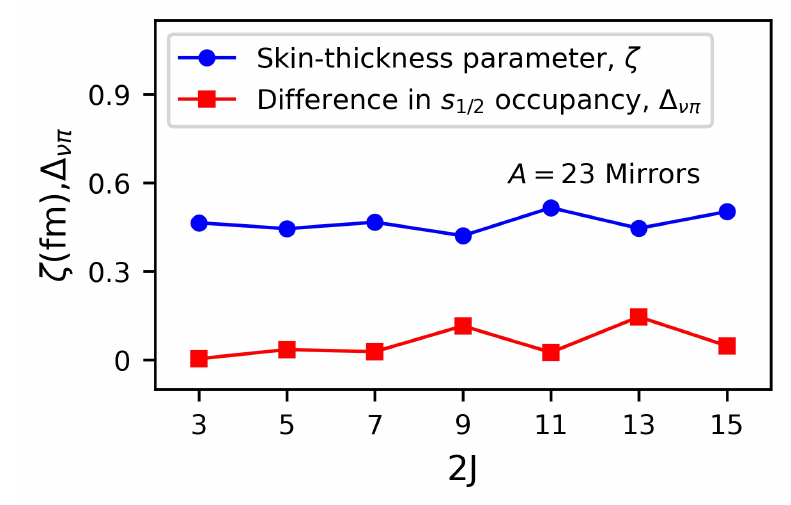
Figure 7. Data from Ref. [11]. Blue circles: the neutron skin thickness parameter, ζ , defined in Ref. [48], which is proportional to difference between the neutron and proton rms radii. This parameter has been extracted through fitting to the measured MED. Red squares: ∆ νπ , the difference between the neutron and proton occupancies of the s 1 orbit, for each state. See text and Ref. [11] for 2